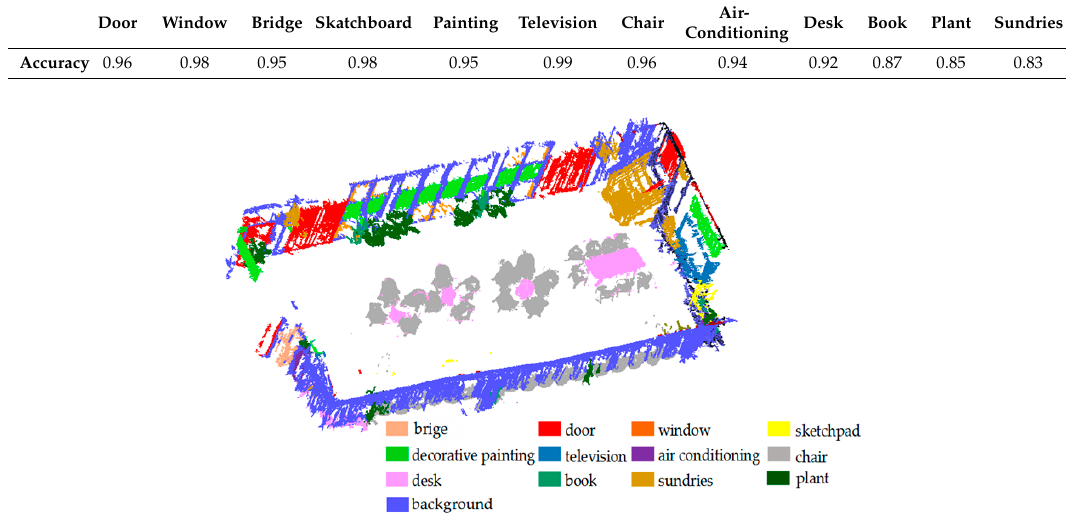
Figure 8. The partial semantic segmentation result on 2D images of the meeting room. The first row shows the input images, while the second row are the corresponding semantic segmentation results. Table 8. The semantic segmentation performance on 2D images.